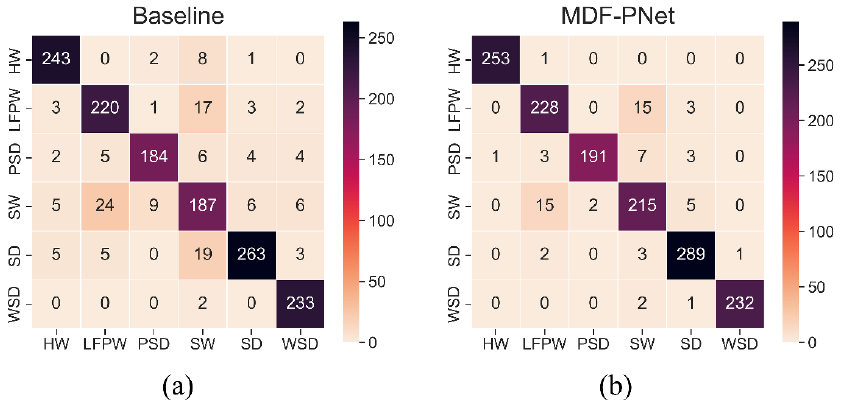
Figure 11. Confusion matrix of baseline and MDF-PNet on the same batch of samples. ( a ) Baseline and ( b ) MDF-PNet.